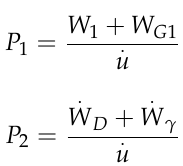
Figure 8. Idealized model for anchorage segment.